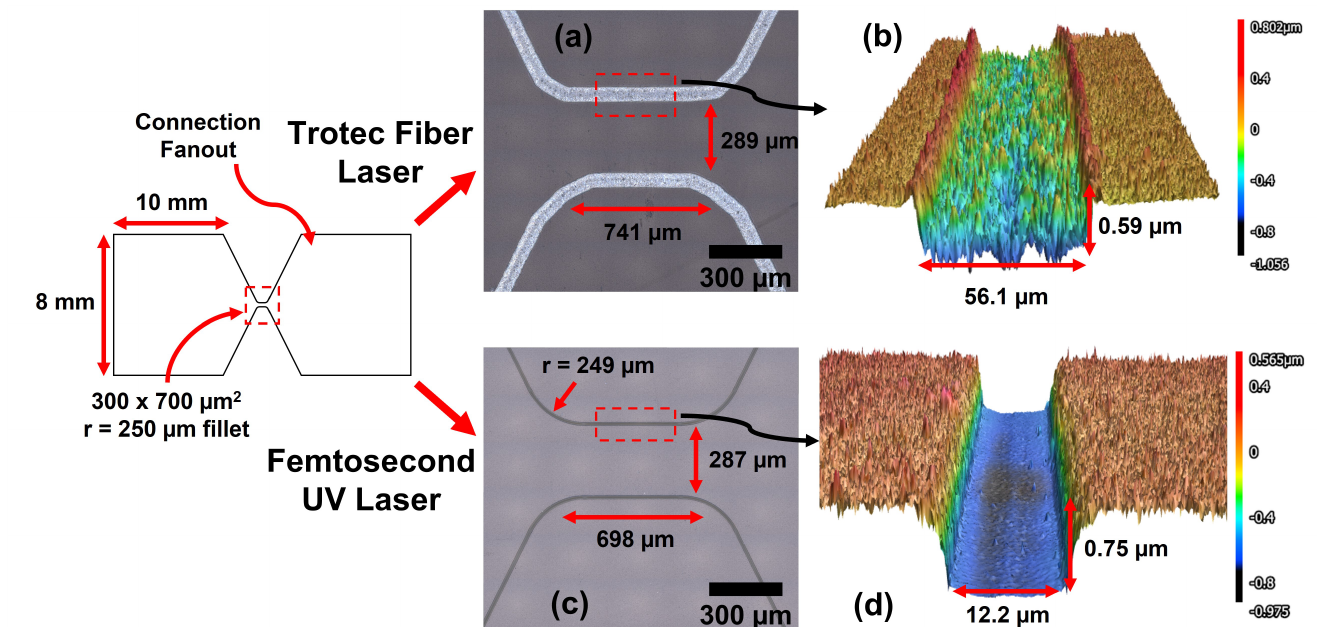
Figure 3. Resistor Fabrication Method and Cut Quality—depicts the laser cutting process and cut quality from both the Trotec fiber laser and femtosecond UV laser systems in a single line vector cut. CAD software, Autodesk Fusion 360, was used to generate a dxf file defining the resistor. ( a , b ) the FTO film was cut using the Trotec fiber laser with the following cut settings: power = 20%, speed = 0.71 mm/s (0.02% of max speed), PPI/Hz = 30,000, dpi = 500, and passes = 2. ( a ) illustrates the cut quality from the Trotec fiber laser system. The positioning system lacks sufficient resolution to fully resolve the 250 µ m fillet on the resistor edges, but the dimensions of the resistor closely matched that of the dxf design. ( b ) shows the 3D cut profile in which the cut width was 56.1 µ m with a depth of 0.59 µ m. ( c , d ) the FTO film was cut using the femtosecond UV laser with the following cut settings: power = 0.643 W (100%), repetition frequency = 250 kHz, fluence = 7.00 J/cm 2 , speed = 500 mm/s, and passes = 5. ( c ) shows the cut quality from the femtosecond UV laser system. ( d ) illustrates the 3D cut profile in which the cut width was 12.2 µ m with a depth of 0.75 µ m. FTO coated glass with a sheet resistance of 8 Ω /sq and a film thickness of 340 nm was